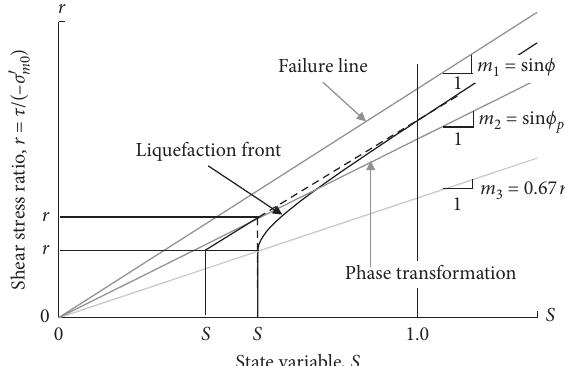
Figure 6: Schematic figure of liquefaction front, state variable S , and shear stress ratio c [24,